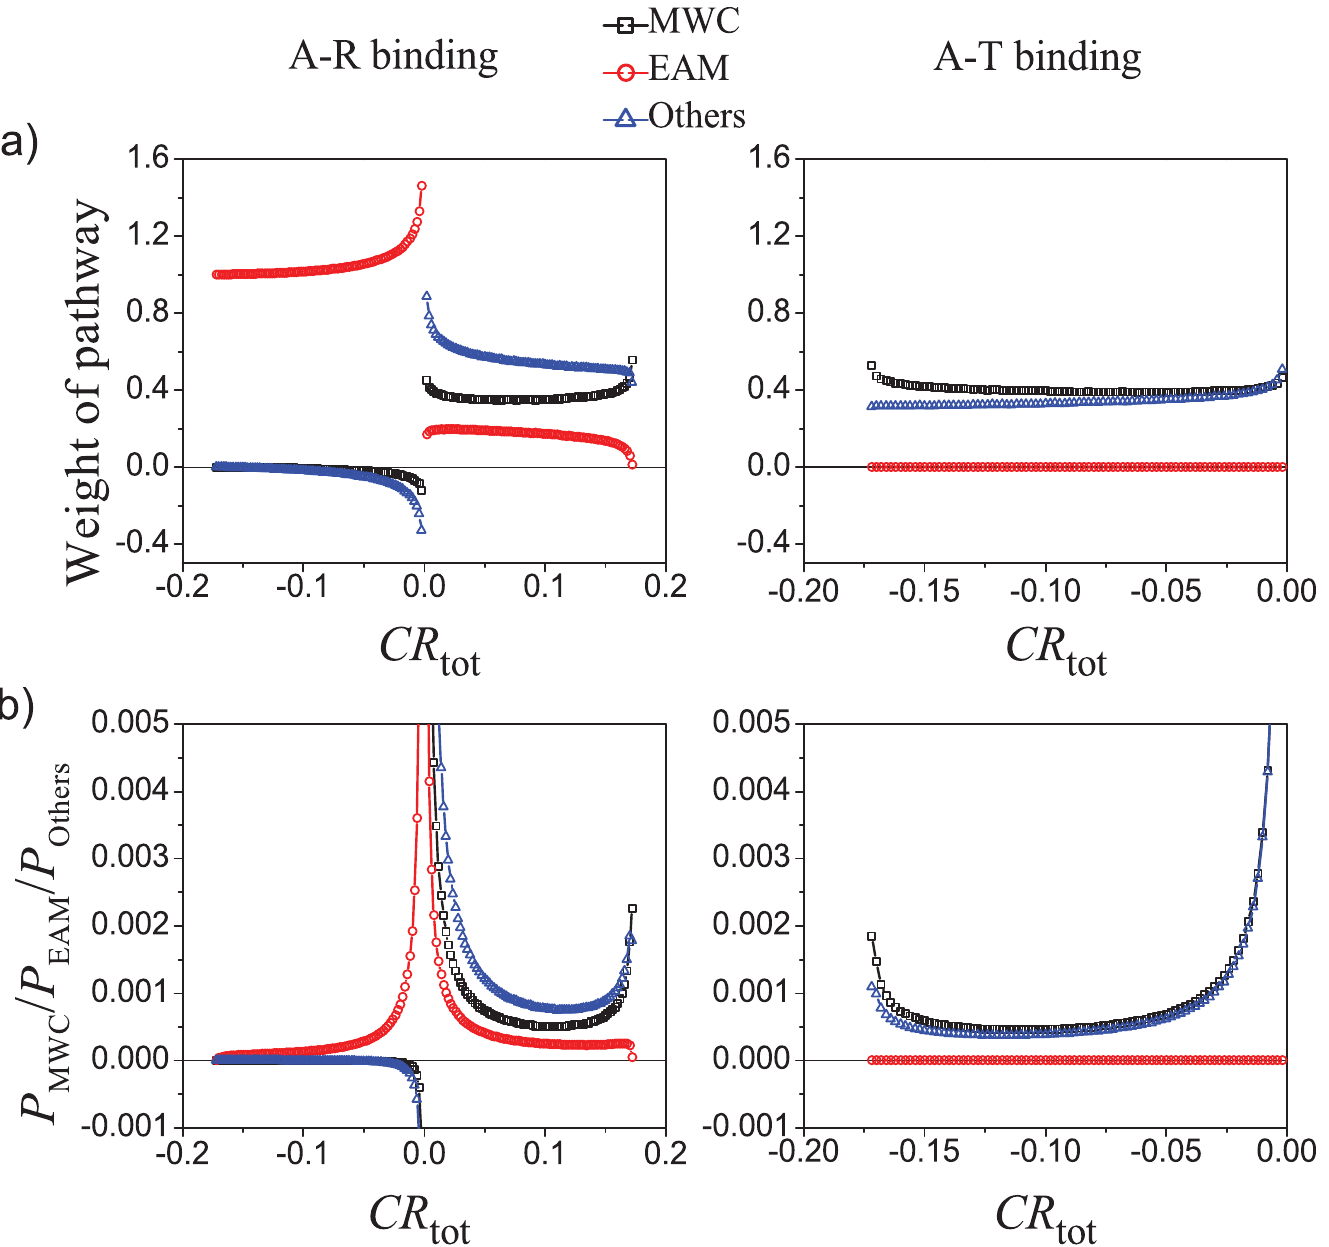
Fig 6. Contributions of three pathways (MWC, EAM, Others) in the comprehensive ensemble model. The stability free-energy parameters ( Δ G R1 , Δ G R2 , Δ G RT1 , Δ G RT2 , Δ g int,R , Δ g int,T ) vary randomly with an equal probability density between − 8 and +8 kcal/mol, resulting in different systems (samples). (a) The average weights of pathways as functions of CR tot . The pathway weights of a system (sample) are calculated based on Eqs 6 and 7. (b) The capacity of three pathways for allostery, being calculated with Eq (12). The A-R binding mode is adopted in left panels and the A-T binding mode is adopted in right panels with Δ g Lig,A = − 3 kcal/mol. It is noted that a large portion of samples practically have CR = 0 and the pathway contributions are ill-defined with Eqs 6 and 7, which are thus